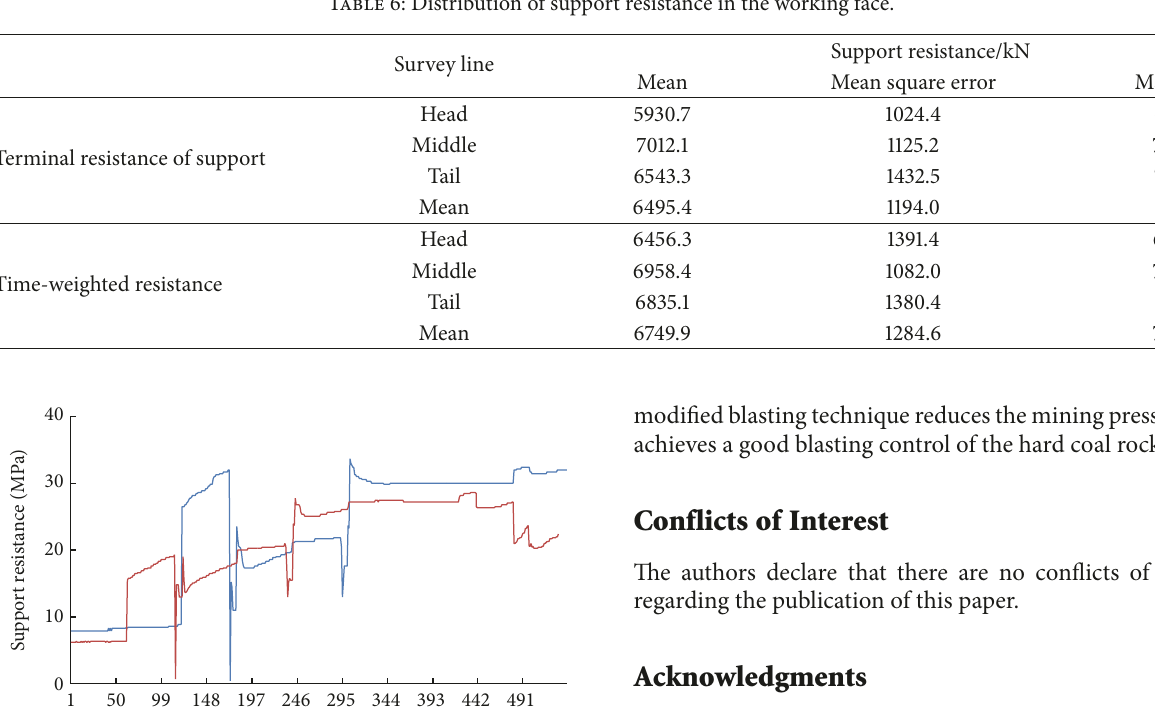
Table 6: Distribution of support resistance in the working face.